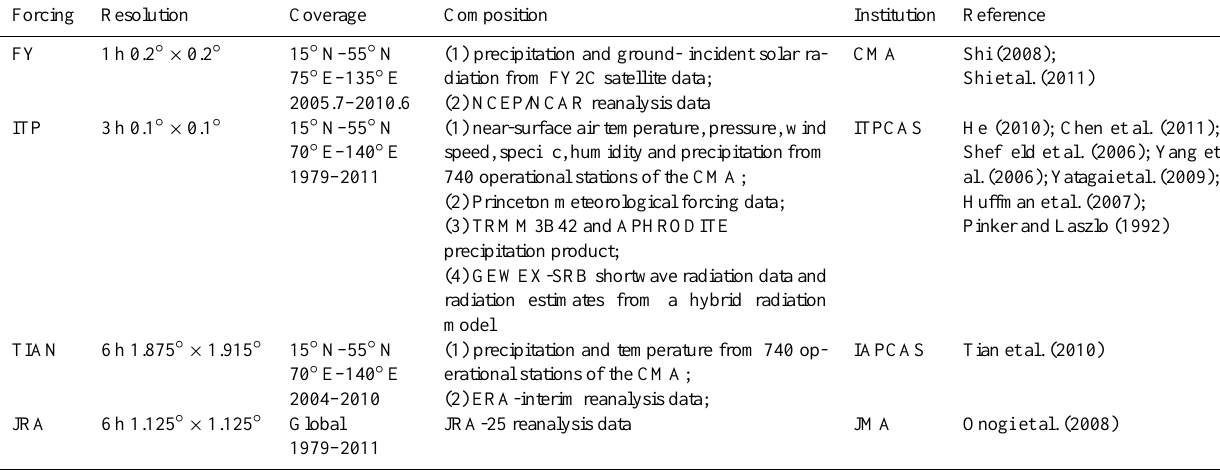
Table 2. Comparison of major features of four sets of meteorological forcing data. Forcing Resolution Coverage